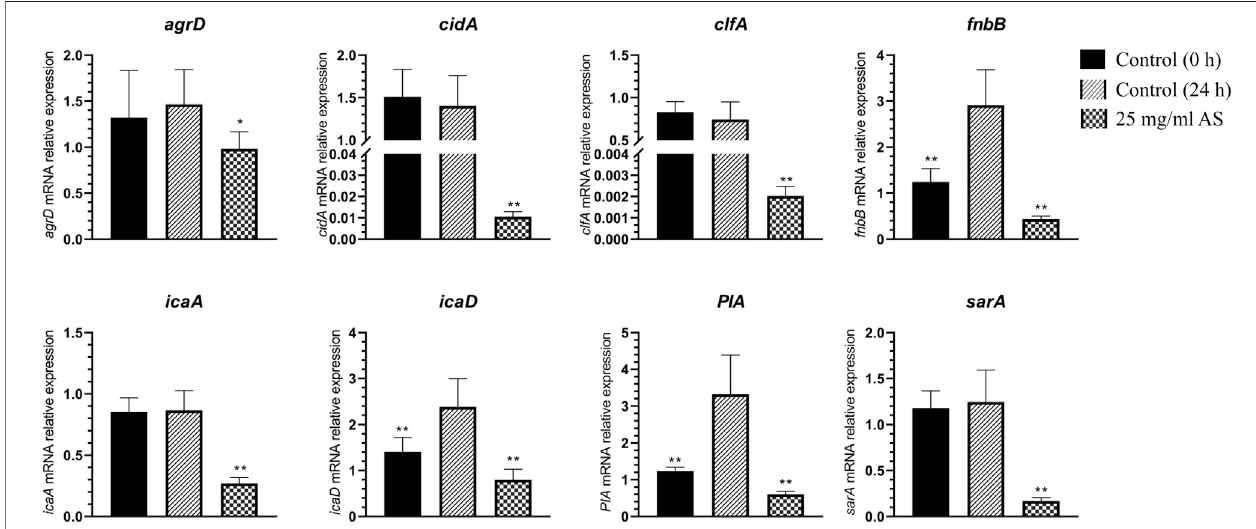
FIGURE 5 | Changes in MRSA gene expression. * p < 0.05, compared with the control (24 h); ** p < 0.01, compared with the control (24 h).